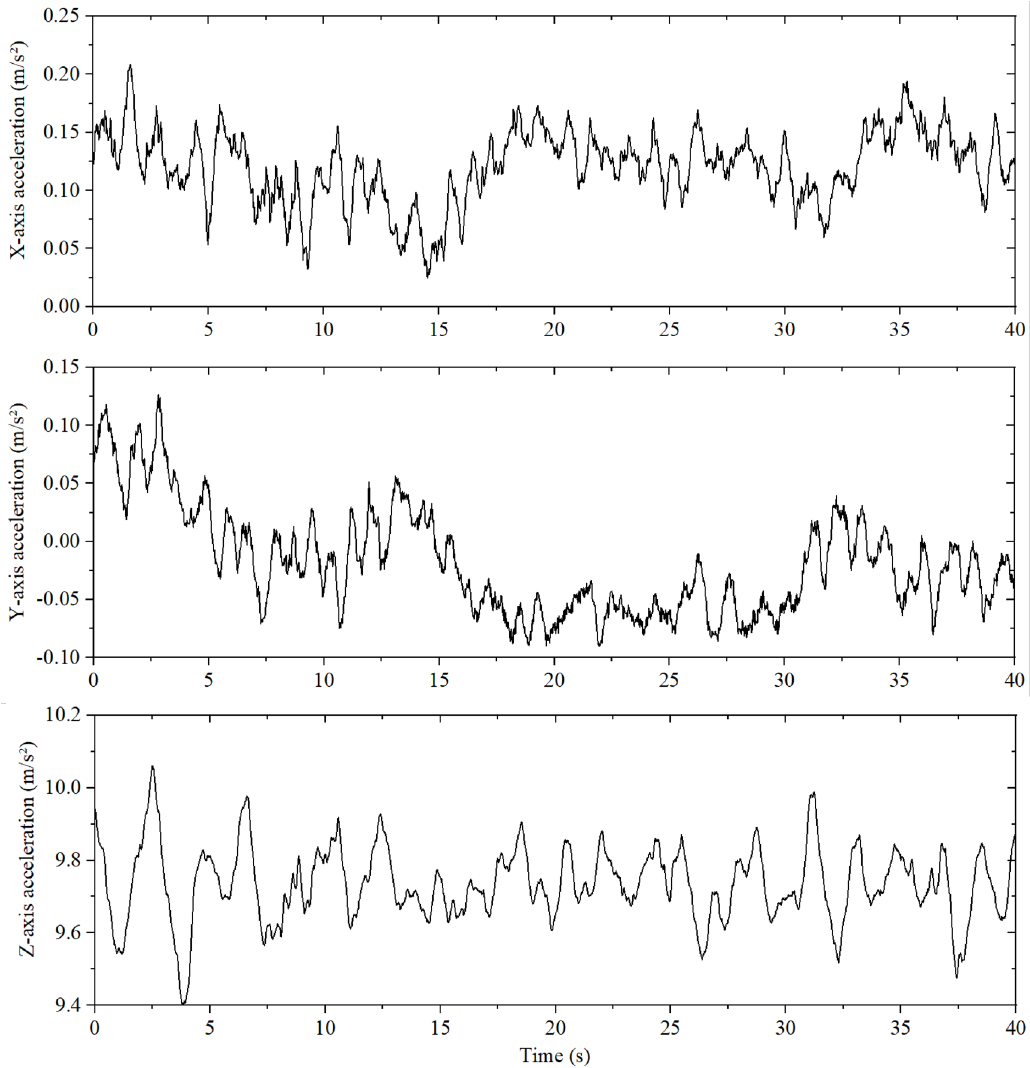
Figure 18. Acceleration variation of flight platform during single-arm reciprocating swing.